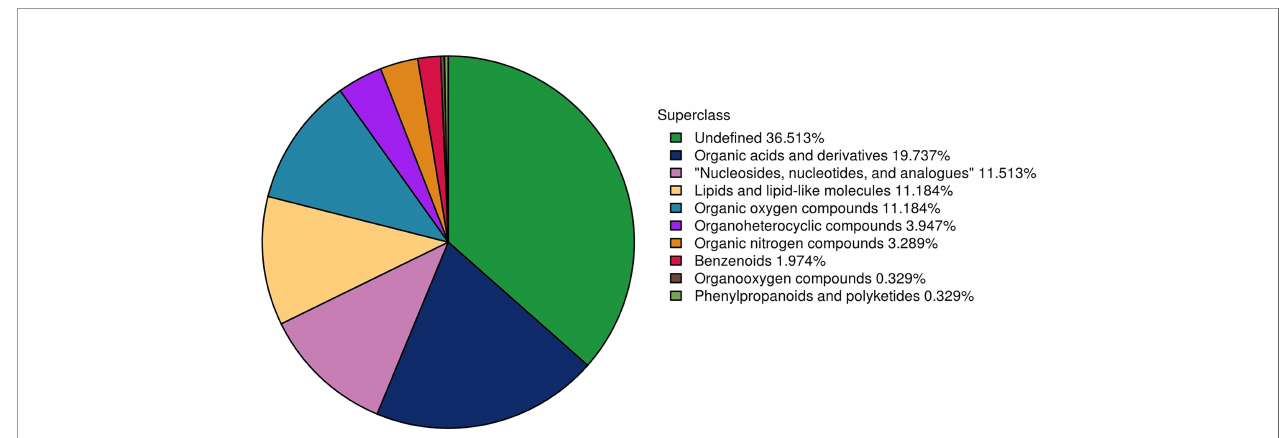
FIGURE 3 | The differential metabolites detected by metabolomics between the treatment group and the control group were classi fi ed according to their chemical